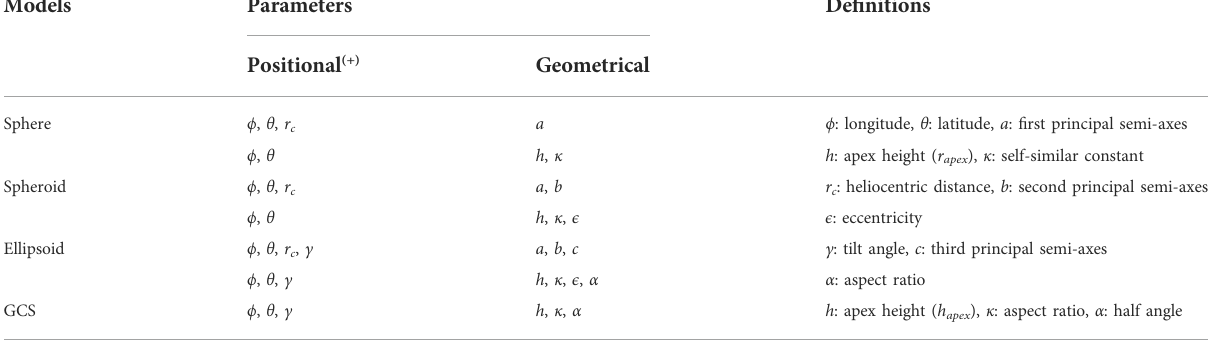
TABLE 2 Geometrical models available in PyThea showing the different parameters